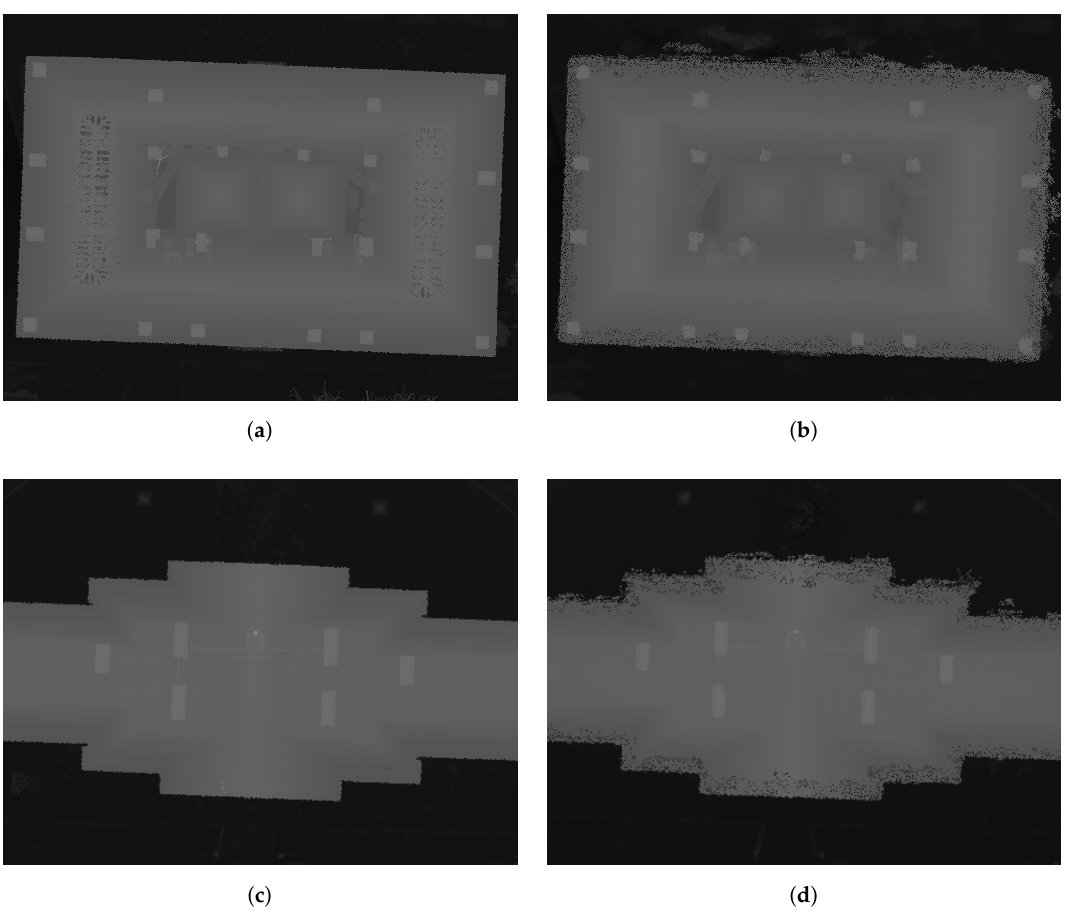
Figure 24. ( a ) Part of the LiDAR-based DSM for the Trinity College study area, and ( b ) DSM generated from the image-matching-based point cloud for the same area; ( c ) Another portion of the LiDAR-based DSM, and ( d ) the corresponding image-matching-based DSM. Cell size is equal to 10 cm in the